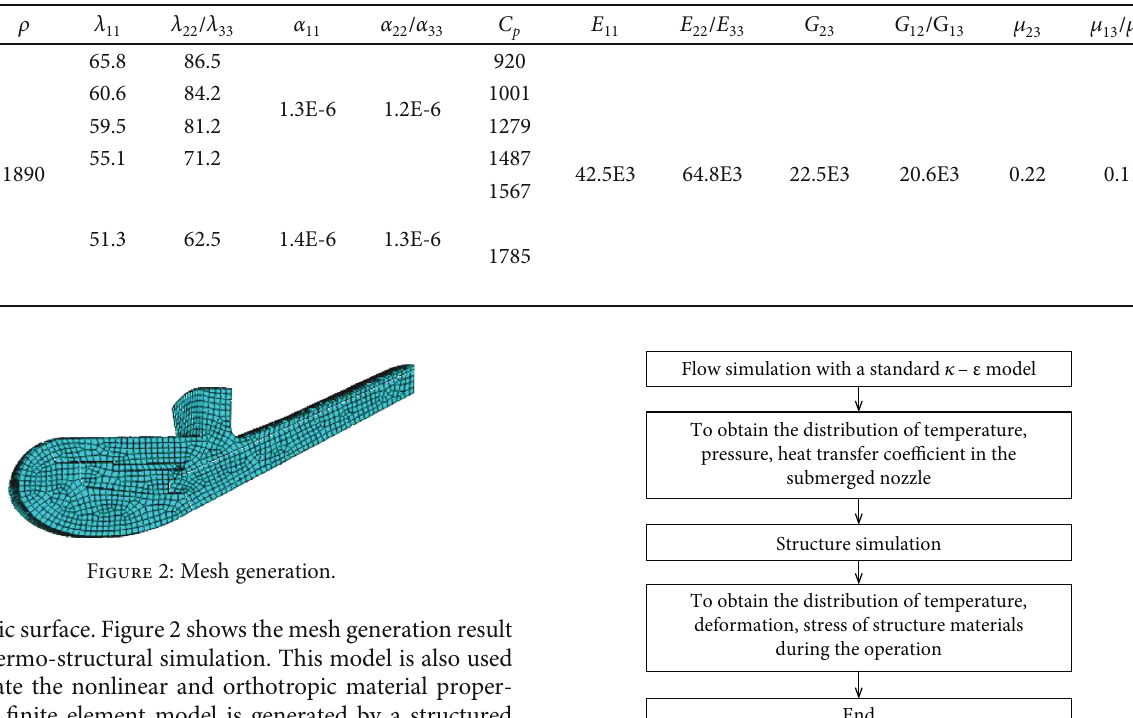
Table 3: Material properties of carbon-carbon composite.